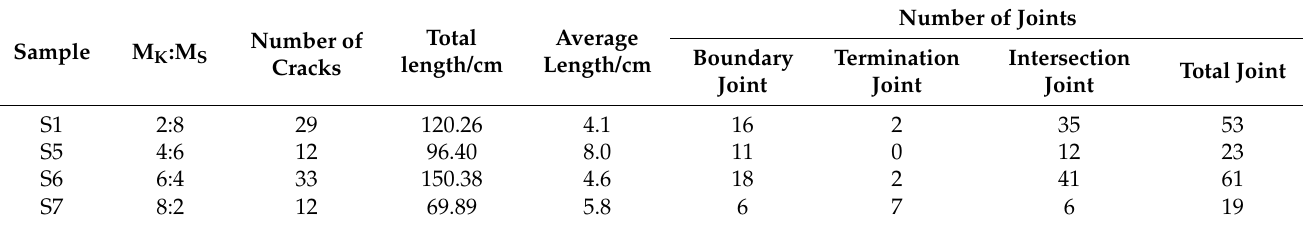
Table 5. Morphological parameters of samples with different values of M K :M S .